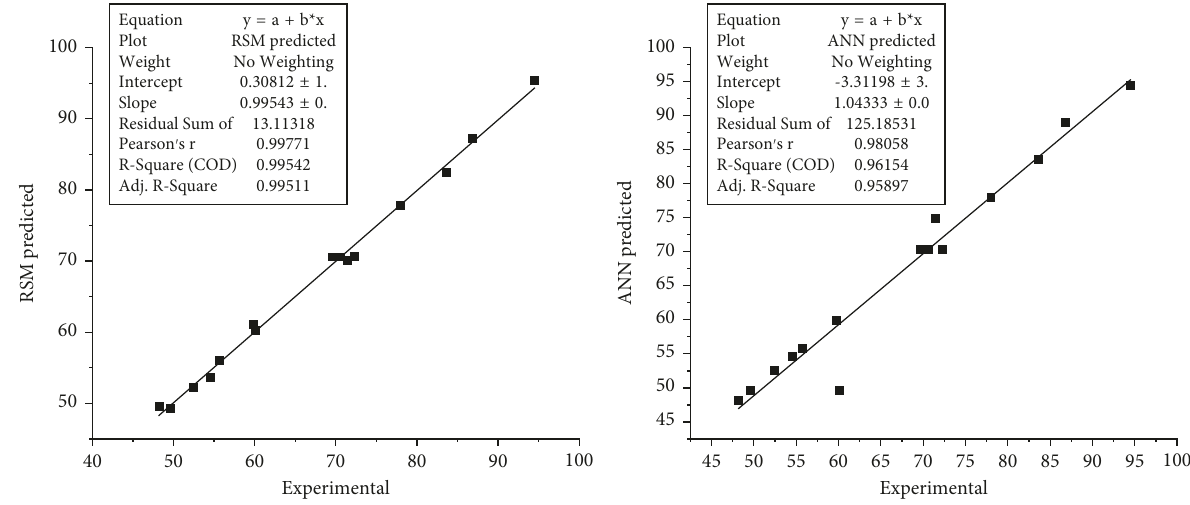
Figure 7: Experimental vs. predicted values for RSM and